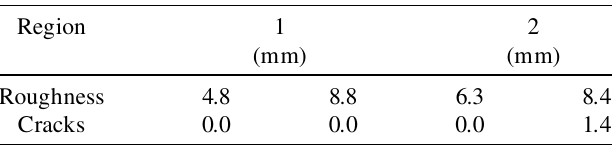
TABLE XII. Widths of regions of surface roughening and cracks for end caps 1 and 2. Region